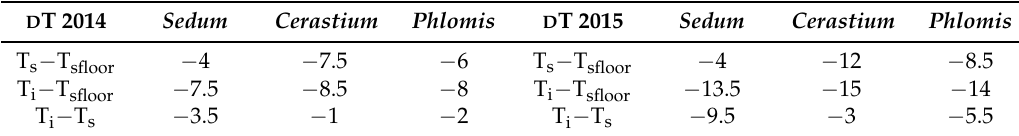
Table 7. Thermal gradients between the paved surface T sfloor , plots T s and T i . D T 2014 Sedum D T